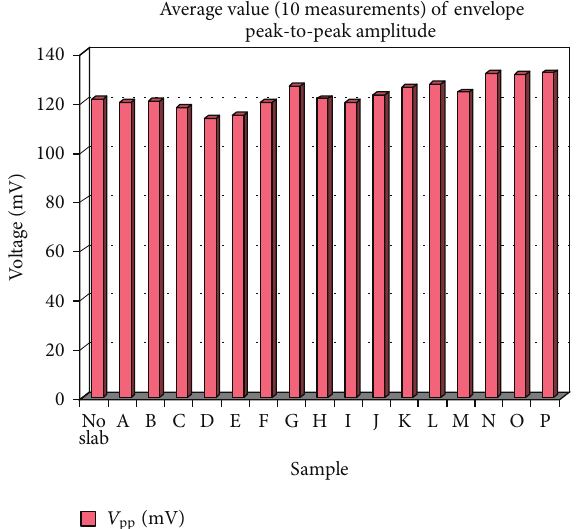
F 9: Peak-to-peak amplitude of the decoded signal picked up on the reader by a custom